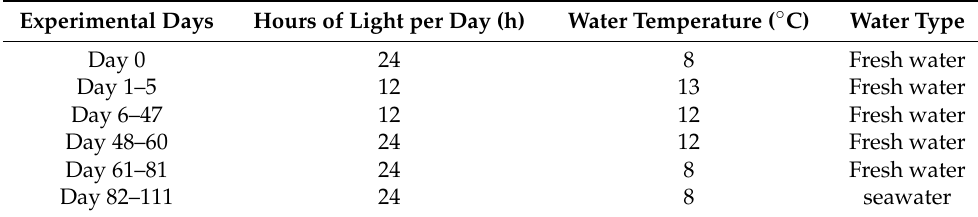
Table 6. Photoperiod and water temperature during the experimental trial. Experimental